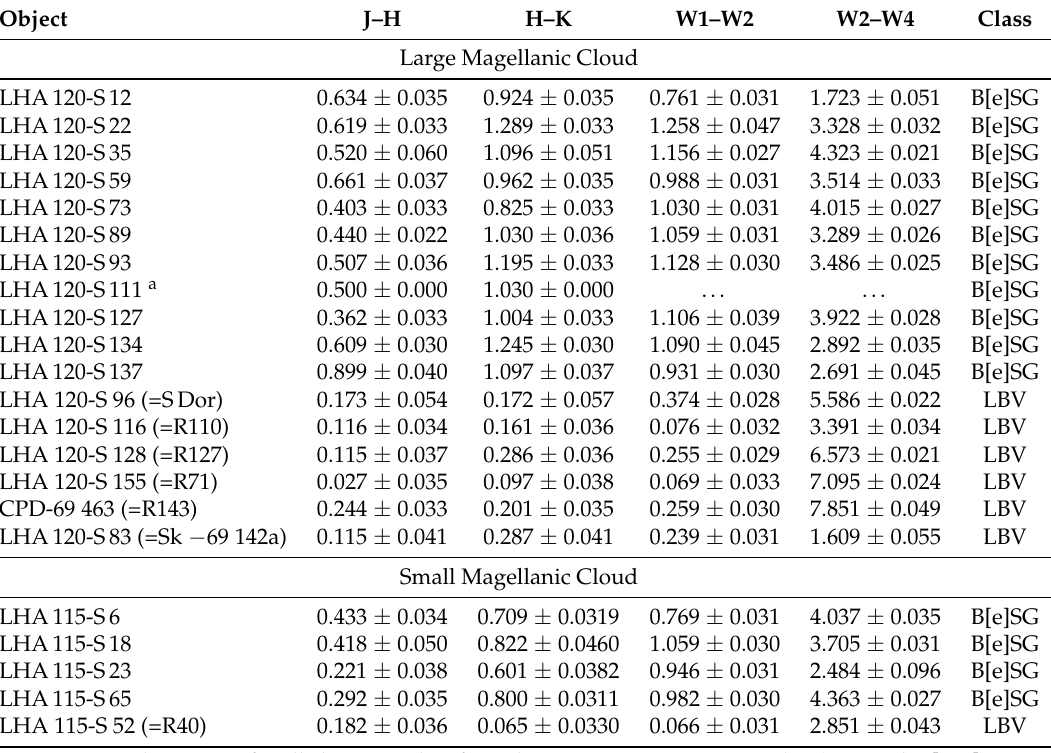
Table 3. IR colors of Magellanic Cloud B[e]SGs and